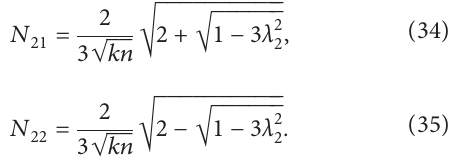
� 0 . 8 ; λ � 0 . 3 ; kn � 5 ; f � 0 . 1 2